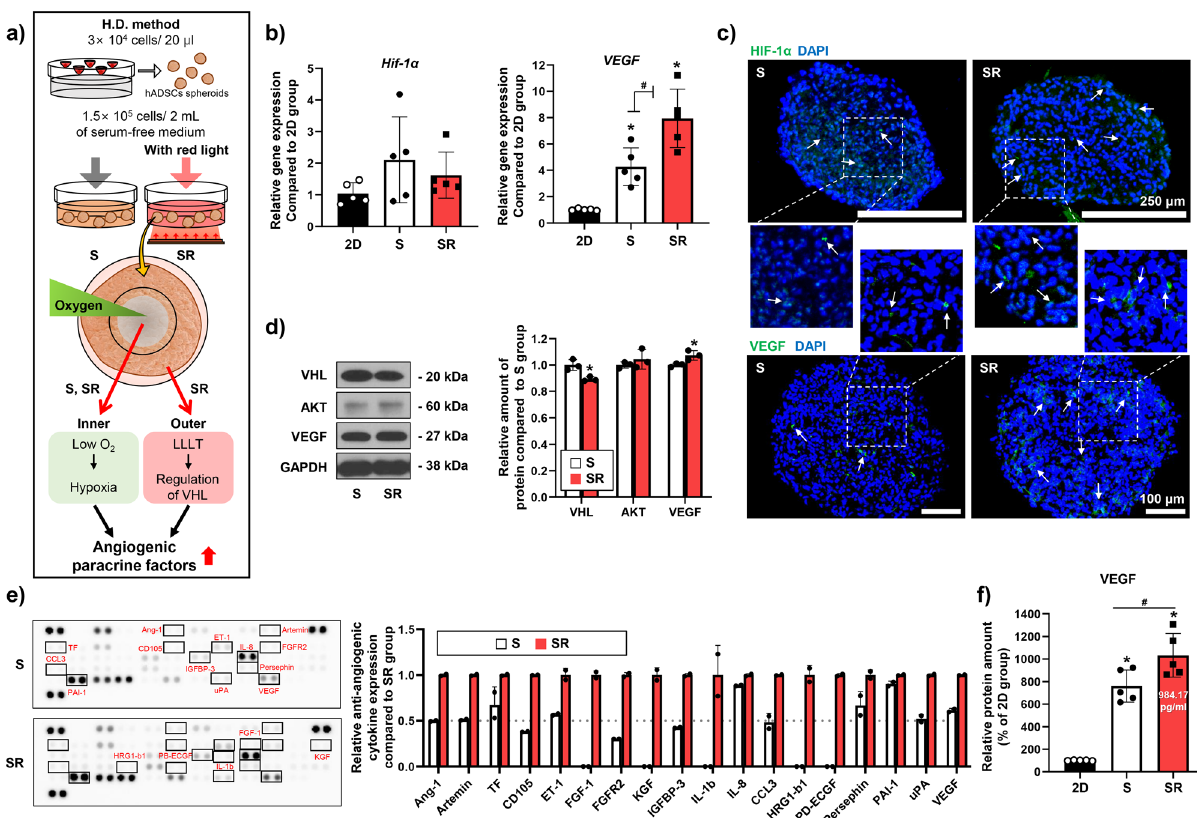
Fig. 2 Secretion of angiogenic paracrine factors of spheroid hADSCs cells following red light stimulation. a Schematic depicting the three-dimensional culture of hADSCs and red light irradiation. b Relative expression of HIF-1 α and VEGF in hADSC spheroids treated with red light ( n = 5, * p < 0.05 vs. 2D group, # p < 0.05 vs. each group). c Representative images of HIF-1 α and VEGF staining in the hADSC spheroids (green, HIF-1 α or VEGF; blue, nuclei). HIF- 1 α (scale bar, 250 um) and VEGF (scale bar, 100 um) are indicated with white arrows. d Western blot analyses of key pro-angiogenesis paracrine molecules in hADSC spheroids treated with red light. Quanti fi cation of the relative protein level ( n = 3, * p < 0.05 vs. S group). e Expression of angiogenesis-related proteins in CM, analyzed using human angiogenesis array. f Concentration of VEGF in the CM derived from 2D culture, S, or SR, as evaluated using enzyme-linked immunosorbent assay (ELISA; n = 5, * p < 0.05 vs. 2D group, # p < 0.05 vs. each group). Data are presented as mean ±